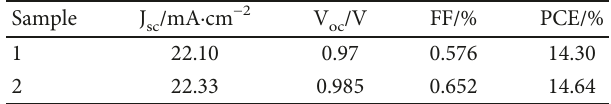
Figure 10: J-V curves of two devices with all optimal processes measured under standard AM 1.5G illumination (100mW/cm 2 ). NH PbI Cl 3 3 3-X X fi Table 3: Photovoltaic performance parameters extracted from J-V curves (Figure